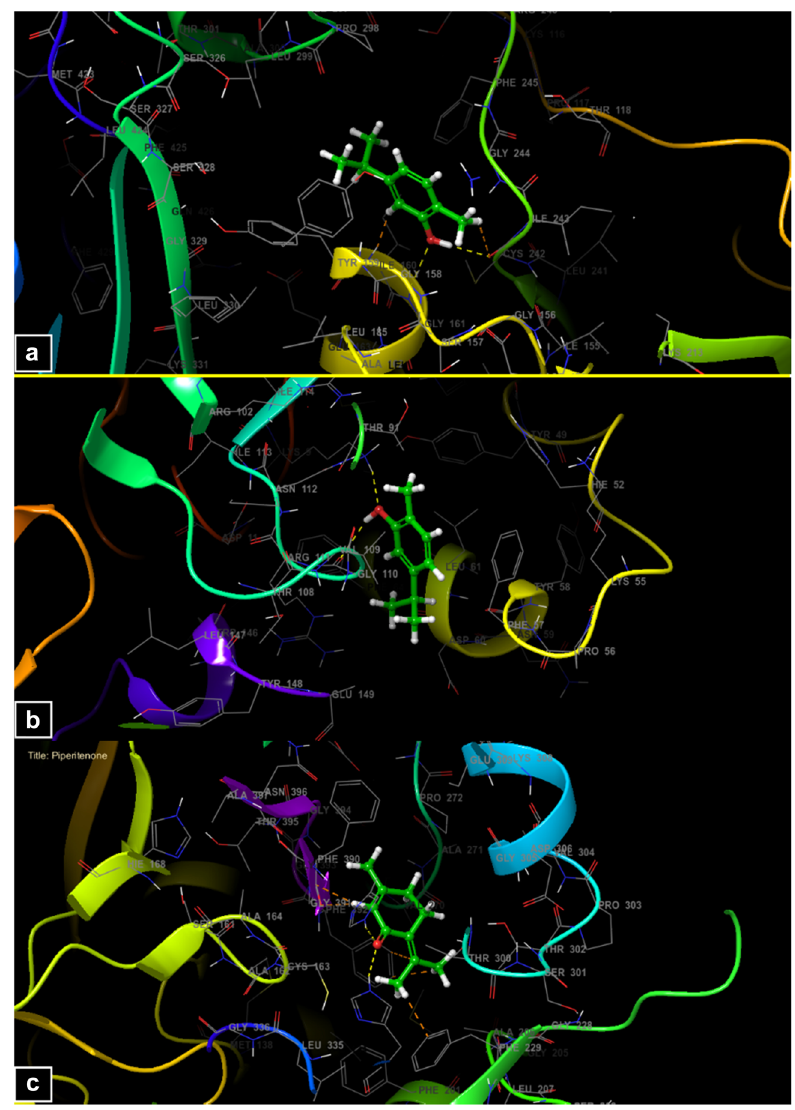
Figure 6: 3D Diagrams of ligands interactions with the active site. ( a ) and ( b ) Carvacrol interactions with the active sites of NADPH oxidase and 3Q8U; ( c ) piperitenone interactions with the active sites of